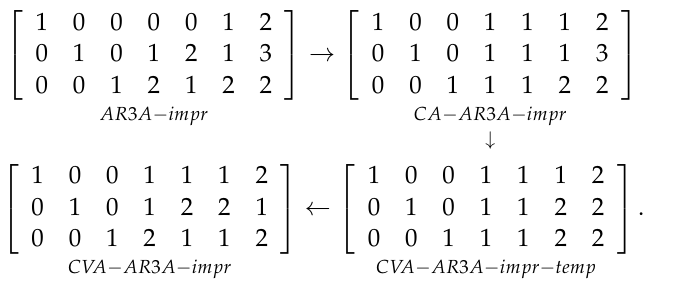
Algorithm 1 optimizes the protomatrices with good compression performance based on the existing codes from [11] by reassigning the degrees of rows and columns. The following Algorithm 1 takes the AR3A-impr codes and the AR4JA-impr codes [11] as an